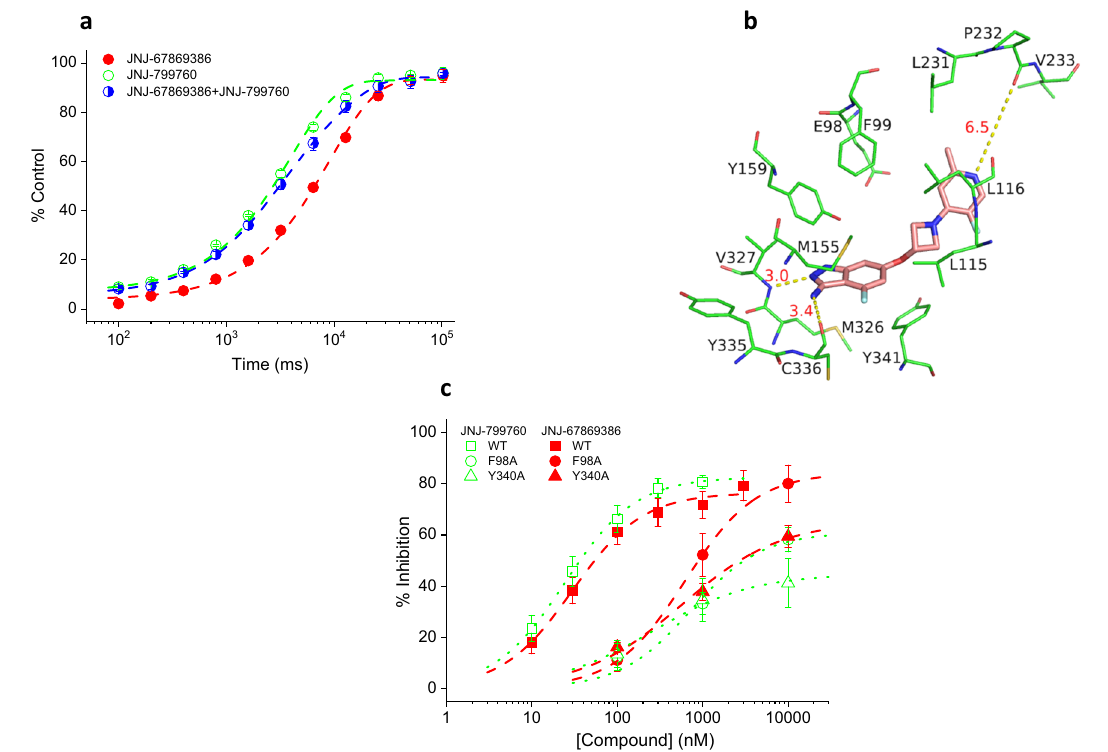
Fig. 10 JNJ-67869386 and JNJ-799760 bind to the same pocket. a Kinetics of current recovery from inhibition by 100 nM JNJ-67869386, 1 µ M JNJ- 799760 or 100 nM JNJ-67869386 + 1 µ M JNJ-799760. The steady-state current in the presence of compound is subtracted before normalization. Data are fi tted to a single or double exponential function (dashed lines) with time constants of 9.1 ± 0.4 s ( n = 11; solid circles), 3.1 ± 0.2 s/14.9 ± 1.6 s ( n = 5; half- fi lled circles) and 3.9 ± 0.2 s ( n = 5; open circles), respectively, for JNJ-67869386, JNJ-67869386 + JNJ-799760, and JNJ-799760. The three groups of data are signi fi cantly different from one another ( p < 0.001; Two-way ANOVA). The holding pH is 8.2. b Docking of JNJ-67869386 (salmon carbons) to the binding site of JNJ-799760 on Δ ASIC1 (green carbons). Stick representation of JNJ-67869386 and channel residues with which it interacts. Speci fi c interactions between JNJ-67869386 and Δ ASIC1 are shown as yellow dotted lines labeled with distances in Å. c Concentration-dependent inhibition of pH 6.0-induced currents of rASIC1a WT, F98A, and Y340A channels by JNJ-67869386 (solid symbols) and JNJ-799760 (open symbols). Data are fi tted to a logistic function (dashed and dotted lines). For JNJ-67869386, IC 50 = 28.9 ± 3.6 nM ( n = 7), 626.3 ± 11.0 nM ( n = 4) and 571.8 ± 176.9 nM ( n = 5), respectively. For JNJ-799760, IC 50 = 24.9 ± 1.3 nM ( n = 4), 725.9 ± 356.1 nM ( n = 4) and 260.0 ± 89.8 nM ( n = 4), respectively. All mutant channel data are signi fi cantly different from the corresponding WT ( p < 0.001; two-way